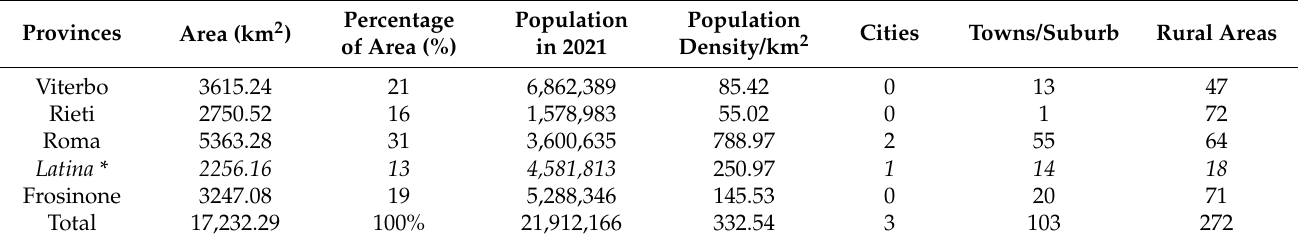
Table 3. The demographic data (reference year 2021) and the administrative structure of the provinces of the Lazio region (based on ISTAT).